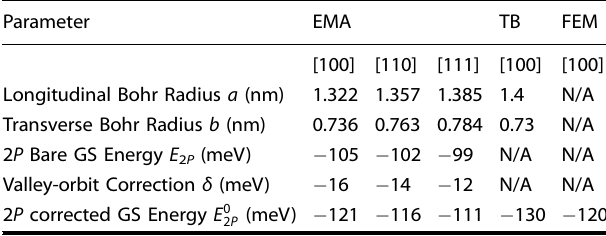
Table 1. Comparison of key metrics of 2P double donor dots using the variational method effective mass approximation (EMA) with the 2 P axis aligned with [100], [110] and